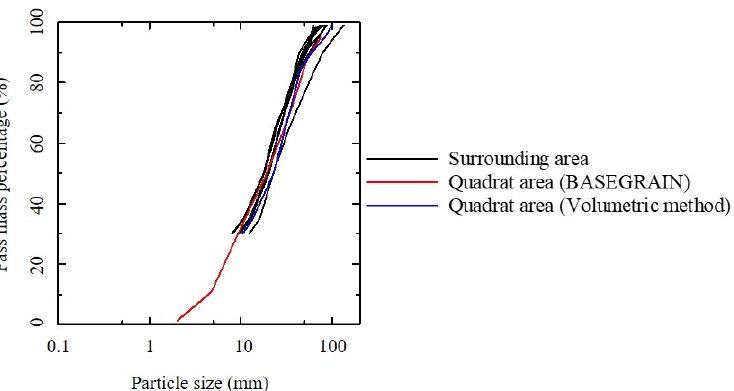
Figure 8. Comparison of the particle size accumulation curve by BASEGRAIN and volumetric methods.